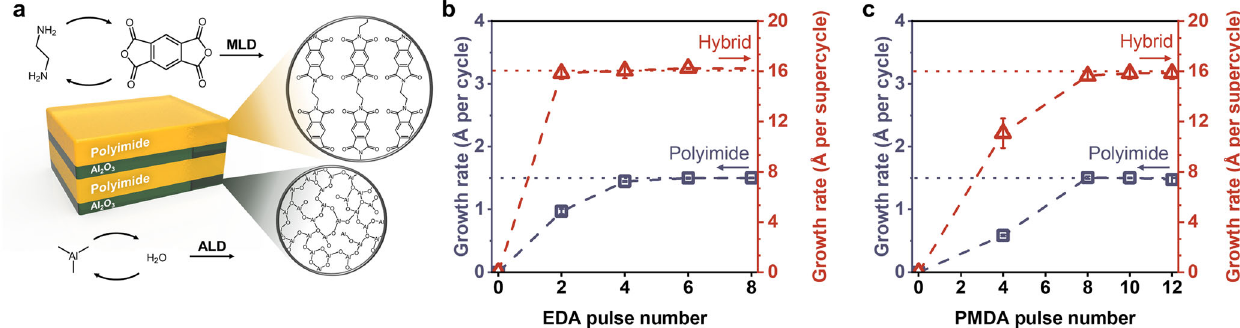
Fig. 1 Deposition scheme of the hybrid dielectrics. a Schematic illustration of the hybrid MLD/ALD process to deposit hybrid polyimide- Al 2 O 3 fi lms. Growth rates of the polyimide and hybrid fi lms with respect to the pulse numbers of b EDA and c PMDA in each MLD cycle or MLD/ALD